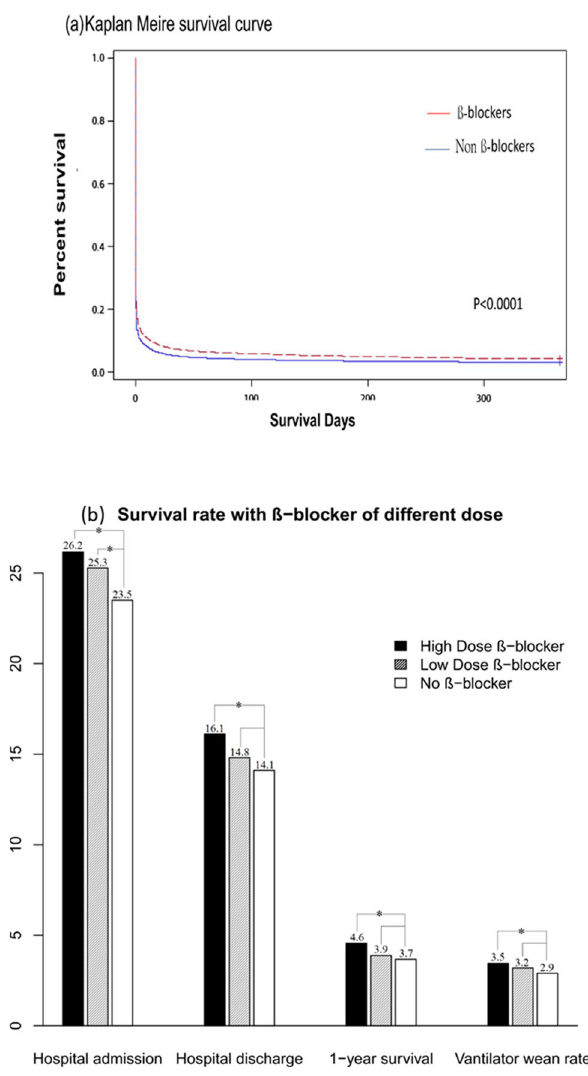
Figure 2. One-year survival rate for cardiac arrest people with or without prior ß-blockers use. ( a ) Kaplan– Meier one year survival curve in patients with/without prior ß-blockers use. ( b ) Multiple logistic regression analysis of (1) survival to hospital admission (2) survival to discharge (3) one year survival rate (4) weaning off ventilator rate among patients receiving high dose, low dose and no ß-blocker (* P < 0.05 by stratified log-rank